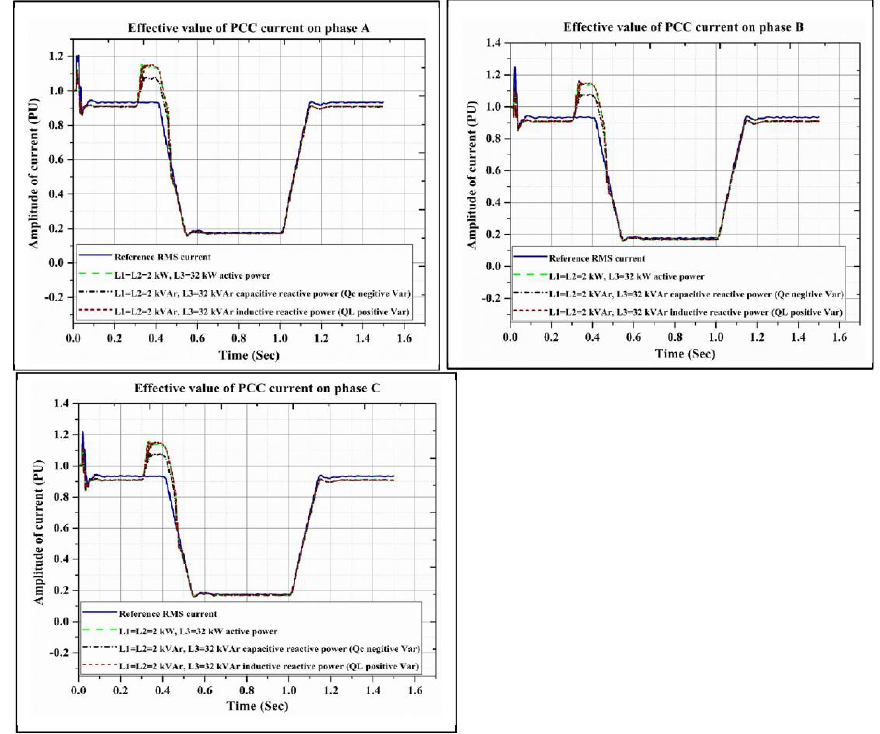
Figure 13. The effective value of PCC current when local loads are smaller than local generation.